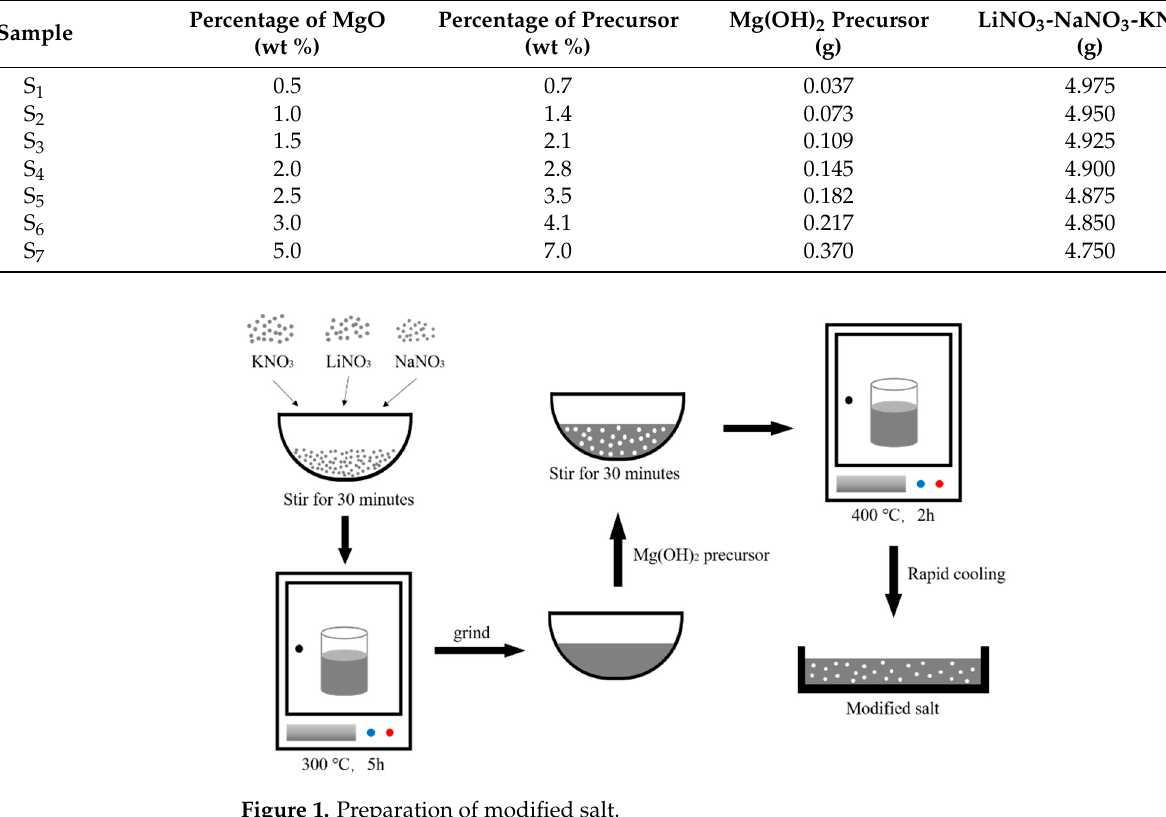
Figure 1. Preparation of modified salt.